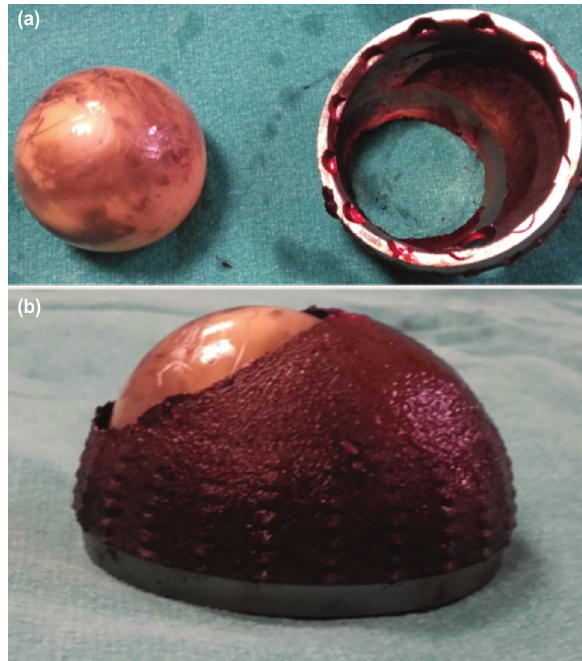
Ceramic femoral head and acetabular cup where the Fig. 2: defect had formed, removed from the patient. The surfaces of the ceramic head and the acetabular component contacting each other (a) and contacting to bone (b).